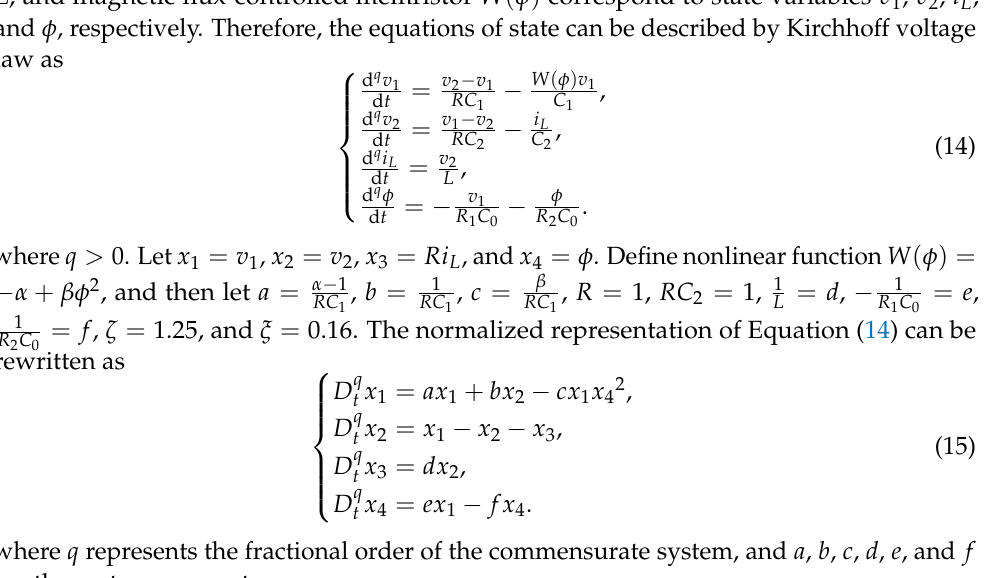
Figure 3. Simulation diagram of fractional-order memristor hysteresis loop circuit in v ( a ) Different amplitudes A ; ( b ) different frequencies f .